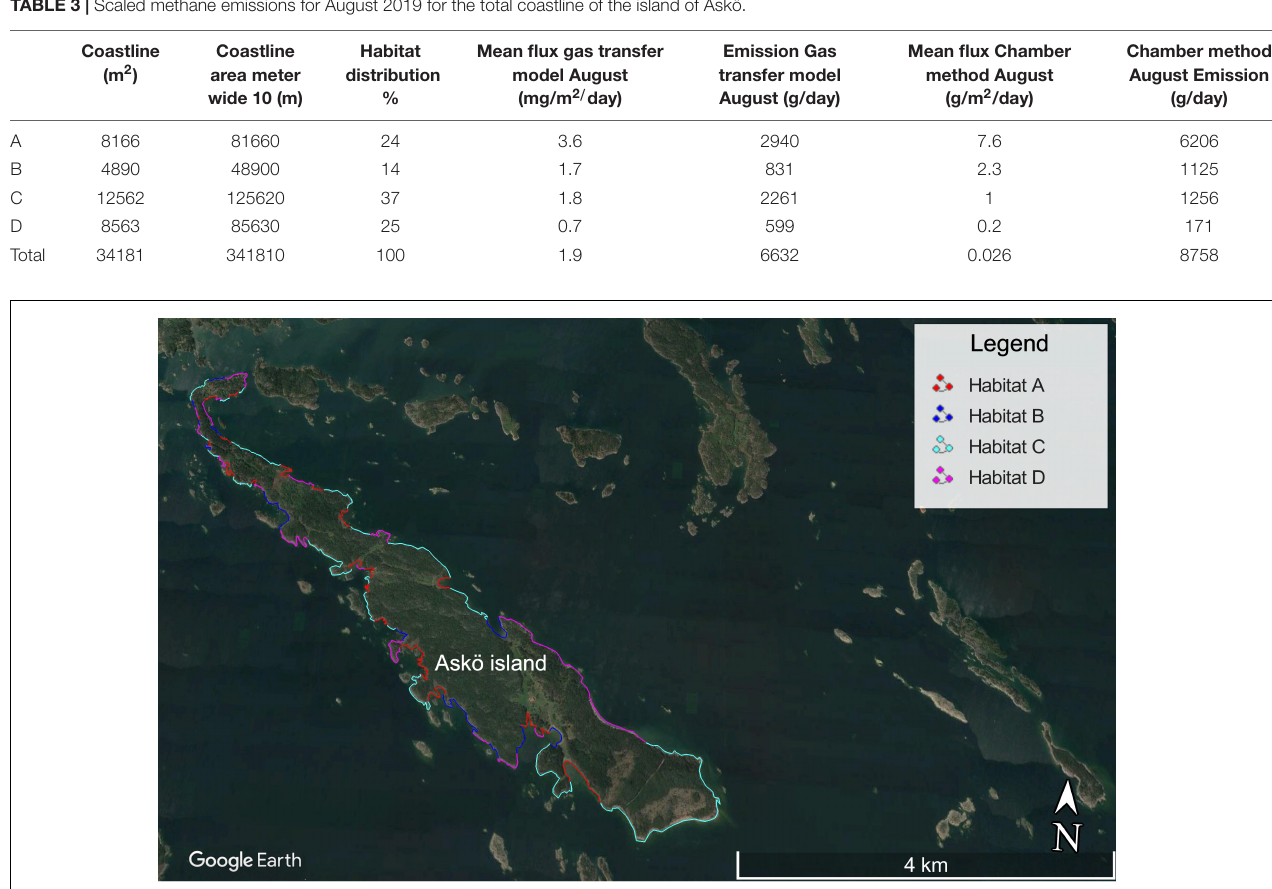
FIGURE 10 | Habitat (A–D) distribution along the Askö